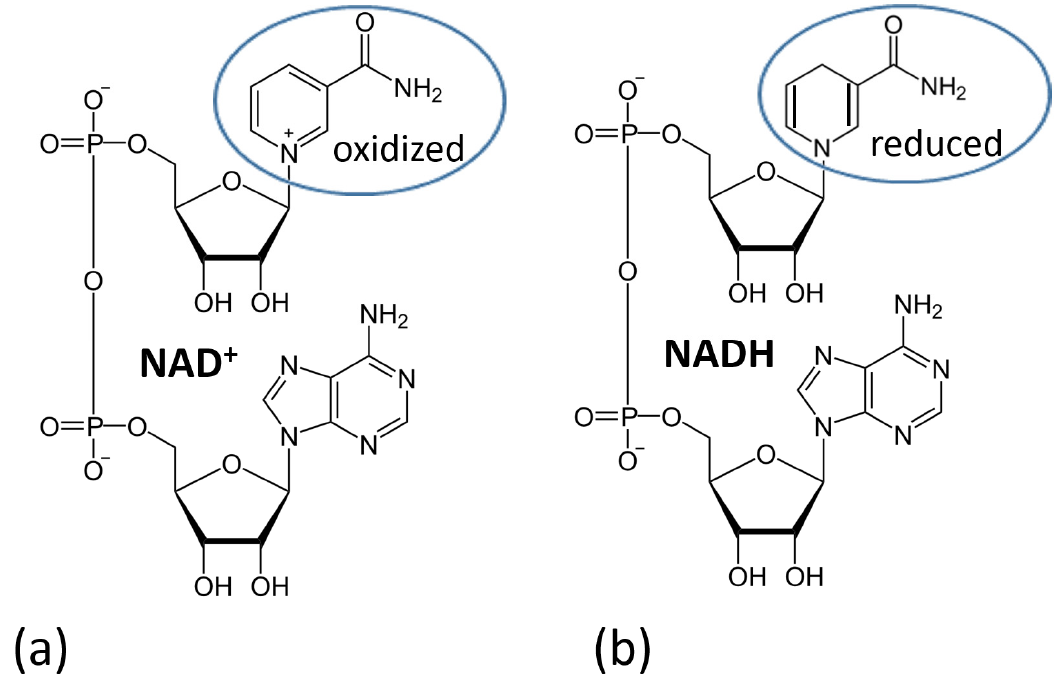
Figure 20. NAD + /NADH cofactor structure in the oxidized ( a ) and reduced ( b ) states. Note that this cofactor is used by NAD + /NADH-dependent dehydrogenases.